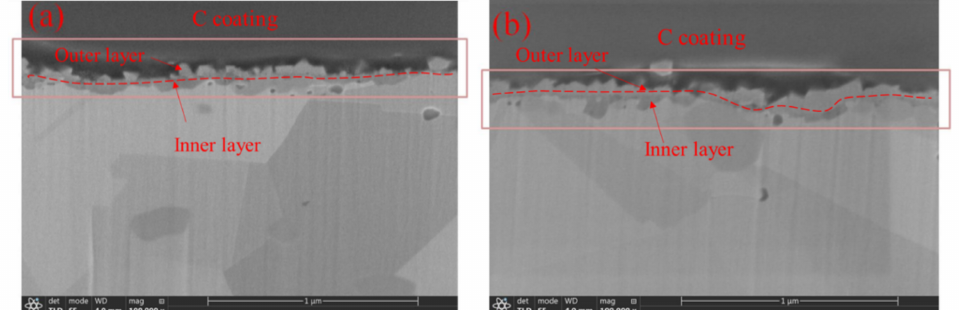
Figure 7. Cross-section morphology of different positions of the SG tube after 500 h of immersion observed by FIB-SEM. The top part is the C coating. The fouling layer is marked by the rectangle and the dash line indicates the interface of the outer layer and inner layer after 500 h of immersion at 290 ◦ C; ( a ) position 1, ( b ) position 2.